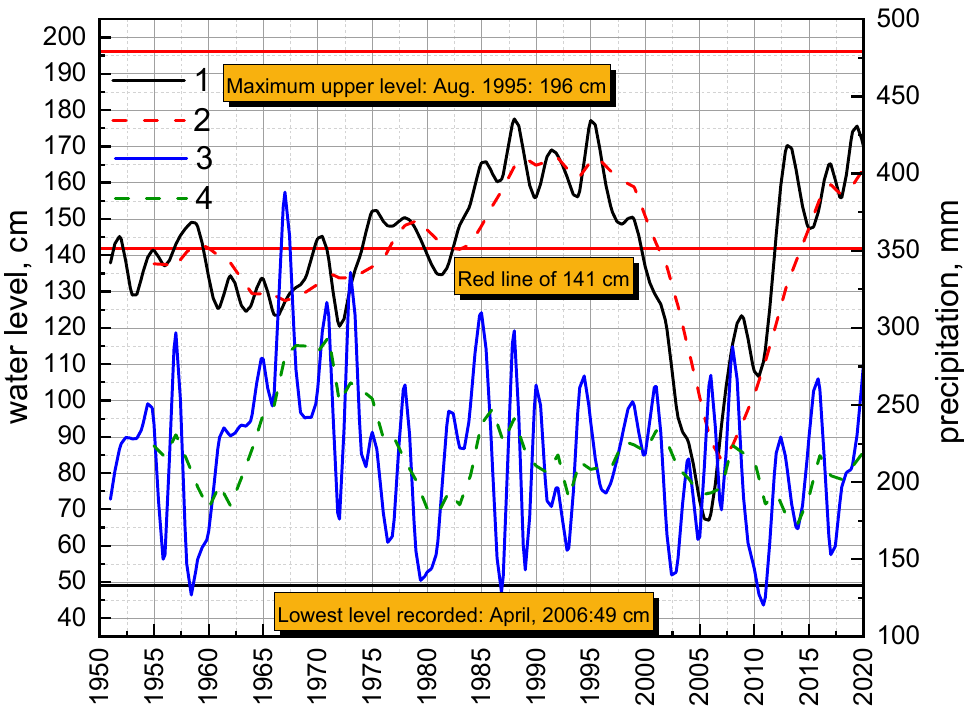
Figure 4. Meteorological data on Lake Gusinoe: ( 1 ) average annual water level in the lake (gauging station at Gusinoe Ozero); ( 3 ) annual average precipitation (Novoselenginsk weather station); five-year running averages of water ( 2 ) level and precipitation ( 4 ).